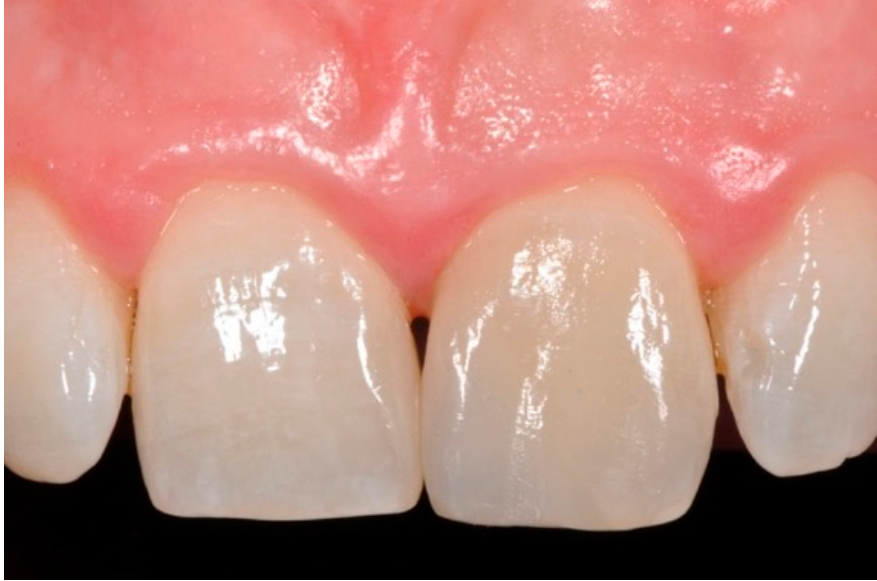
Figure 47. Six months post-operative.